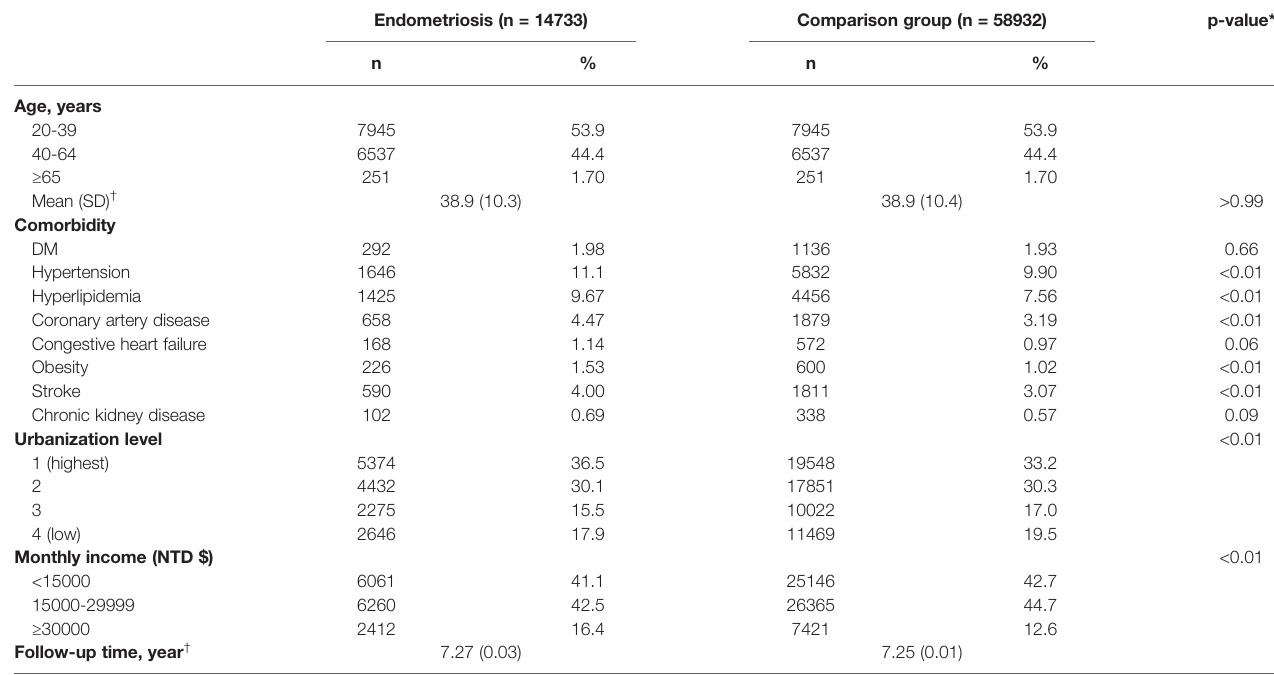
TABLE 1 | Baseline characteristics of